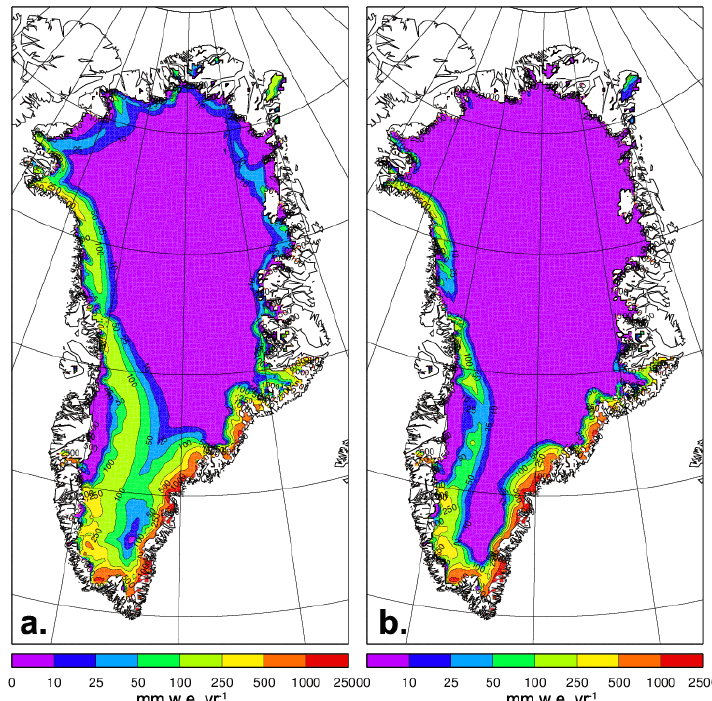
Fig. 10. Difference in refreezing when including capillary water in P r . Both panels show JH2000 minus HdW1999 (Yes–No). (a) d ice = C , (b) d ice = 2m, using RACMO2 input fields.